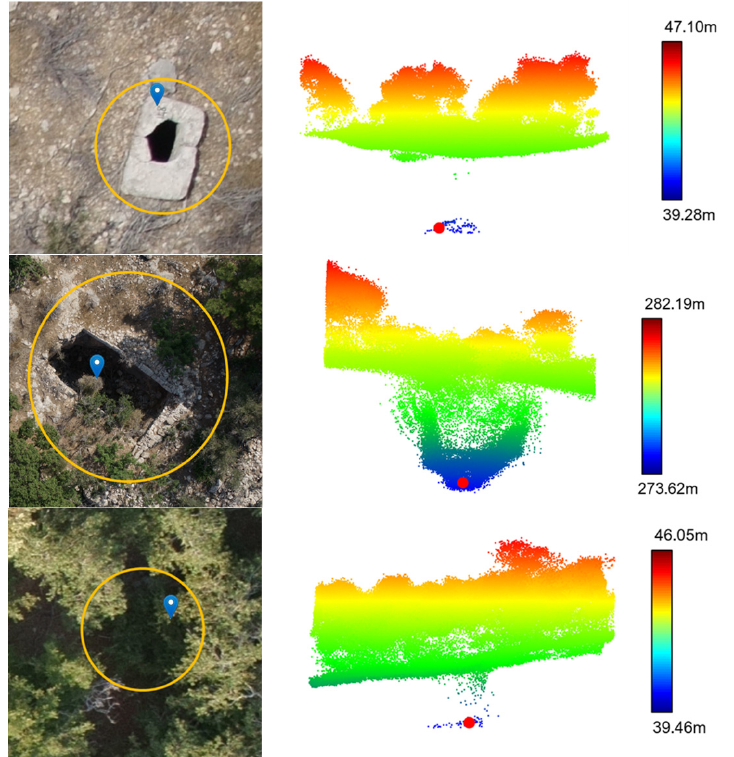
Figure 8. Examples of underground structures in Dana Island; images ( left column ) and corresponding LiDAR point clouds ( right column ).